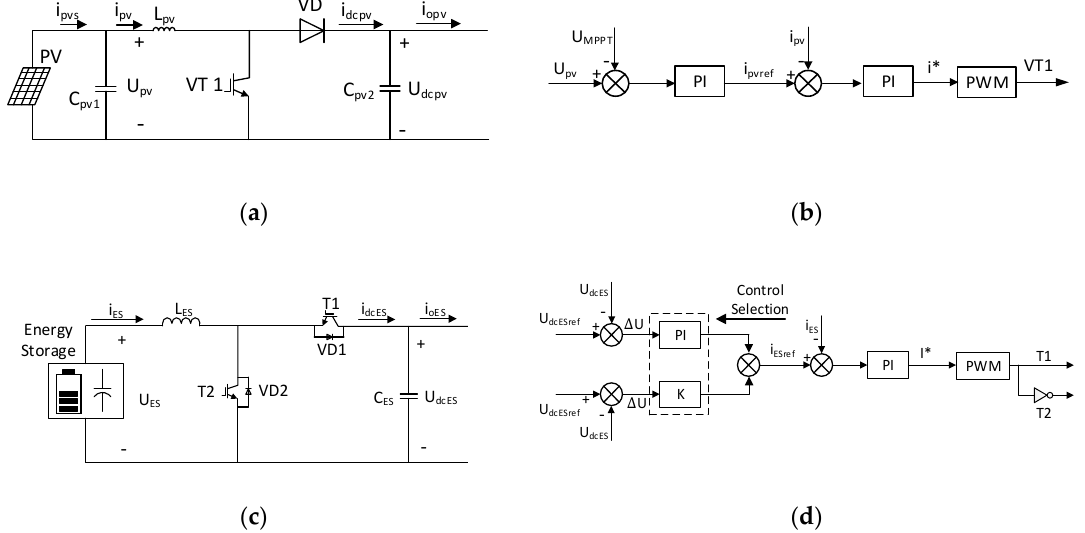
Figure 6. Topology and control strategy of the photovoltaic (PV) and energy storage system (ESS): ( a ) the interface converter for the PV; ( b ) the maximum power point tracking (MPPT) control diagram for the PV; ( c ) The interface converter for the ESS; ( d ) The control strategy for the ESS.